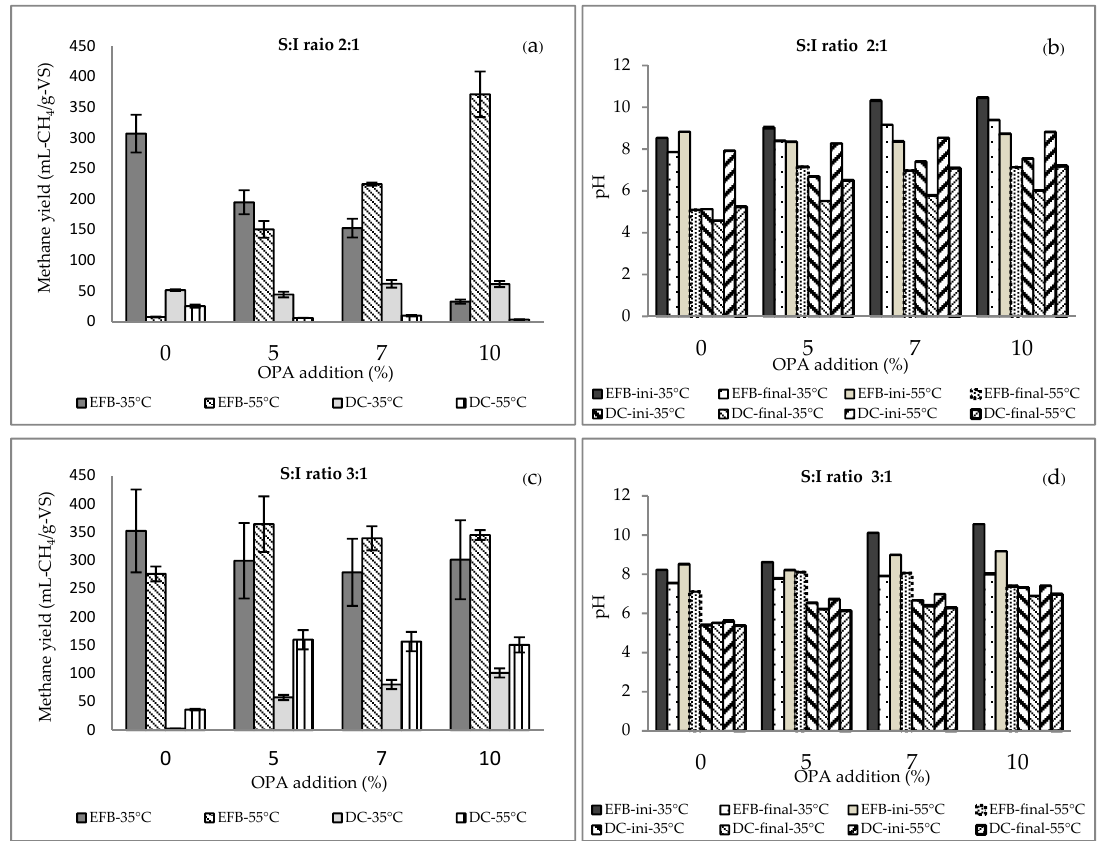
Figure 1. Methane production yield and pH from ( SS - AD ) of empty fruit bunches ( EFB ) and decanter cake ( DC ) at S : I ratio 2 : 1 and 3 : 1 with various % Oil palm ash ( OPA ) addition . Methane yield ( a ) and pH ( b ) at S : I ratio 2 : 1; Methane yield ( c ) and pH ( d ) at S : I ratio 3 : 1 .